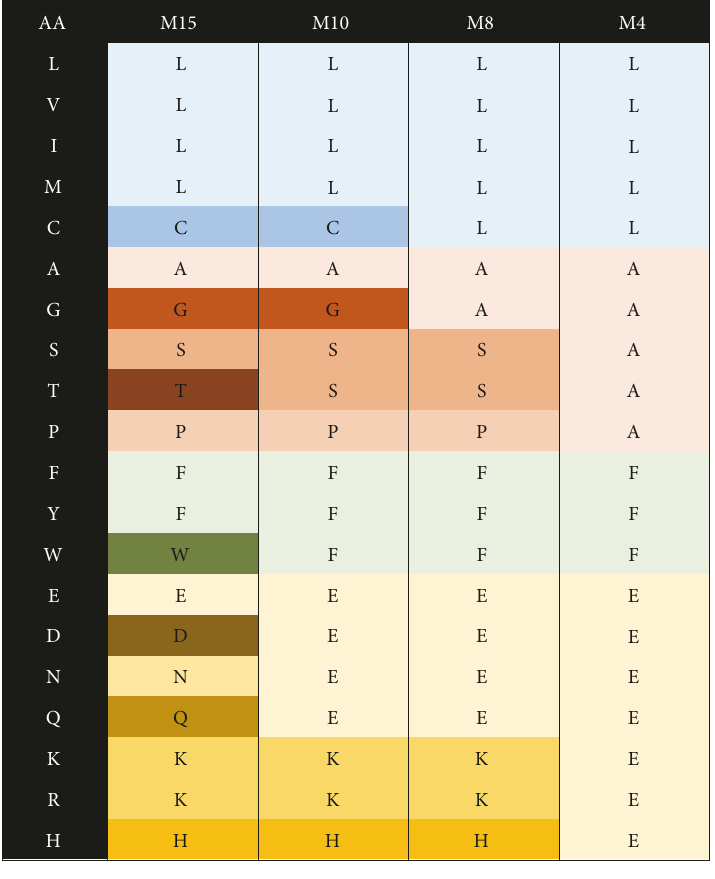
Figure 1: Reduced alphabets utilized for analysis of Vpr amino acid variation. The 20 standard amino acids were grouped according to BLOSUM50 correlations in a hierarchical manner as previously reported in [21]. The resulting alphabets were designated as Murphy-15, Murphy-10, Murphy-8, and Murphy-4. Colors represent amino acids grouped in each alphabet according to physiochemical properties (M15, M10, M8, and M4,